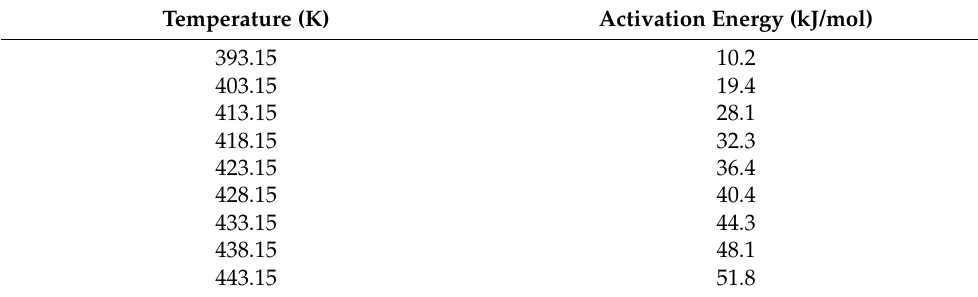
Table 3. Temperature-dependent activation energies from sub-Arrhenius